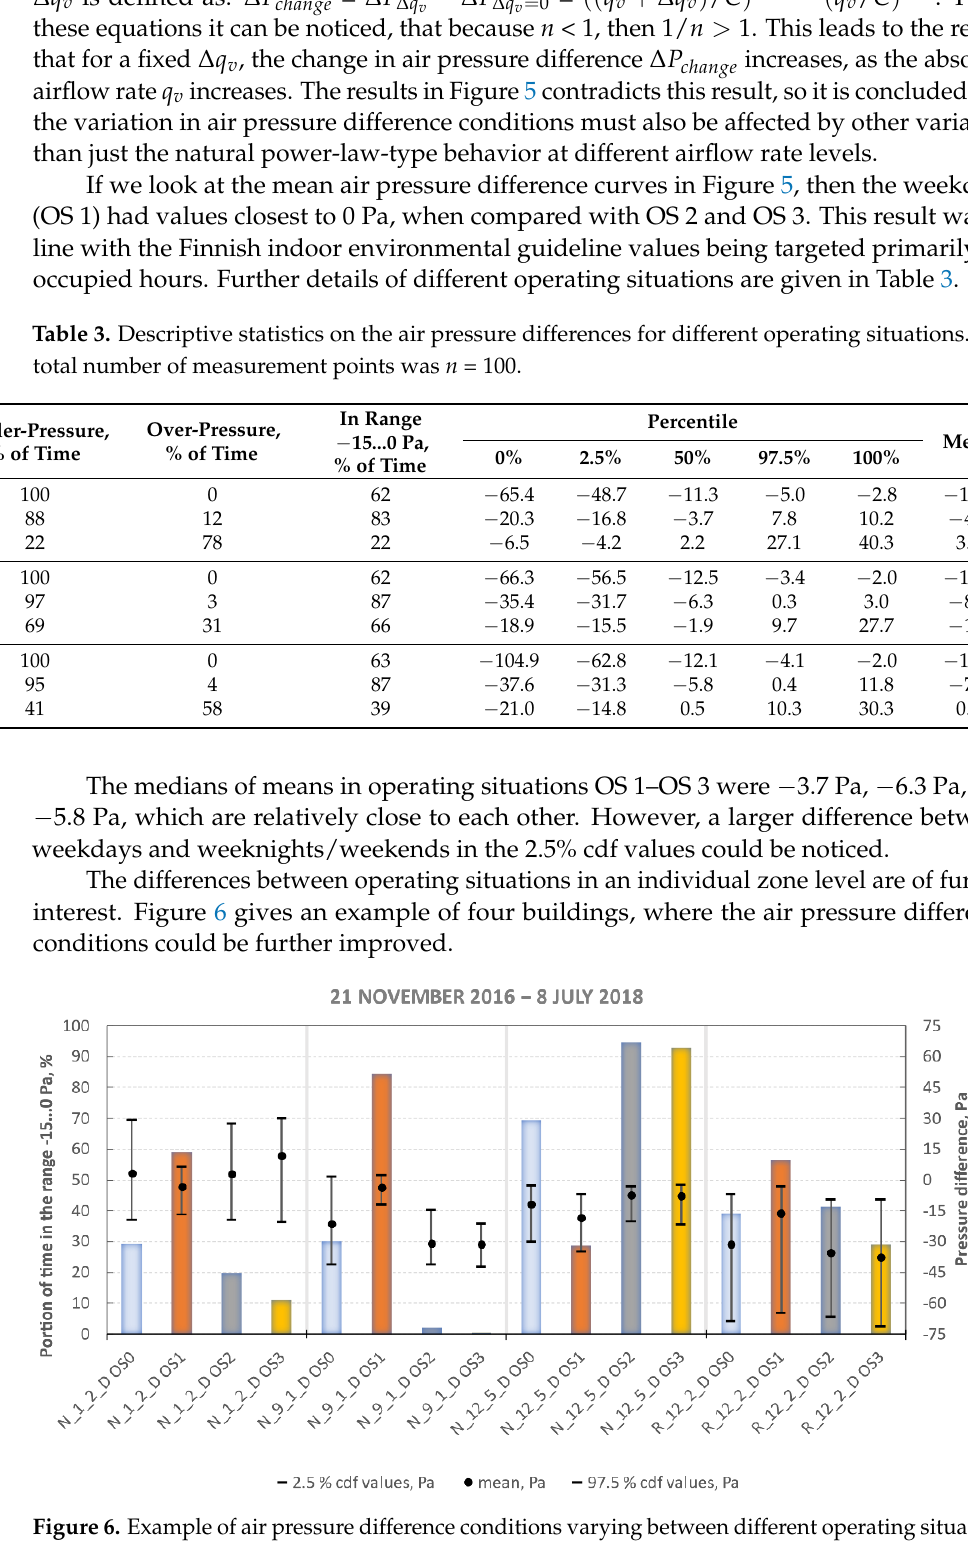
Table 3. Descriptive statistics on the air pressure differences for different operating situations. The total number of measurement points was n = 100.